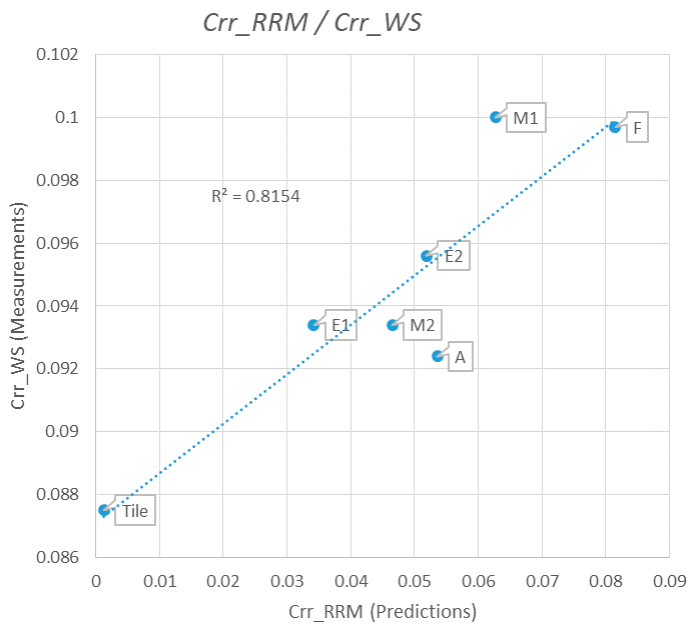
Figure 5. Correlation line between Crr_ RRM and Crr_WS.